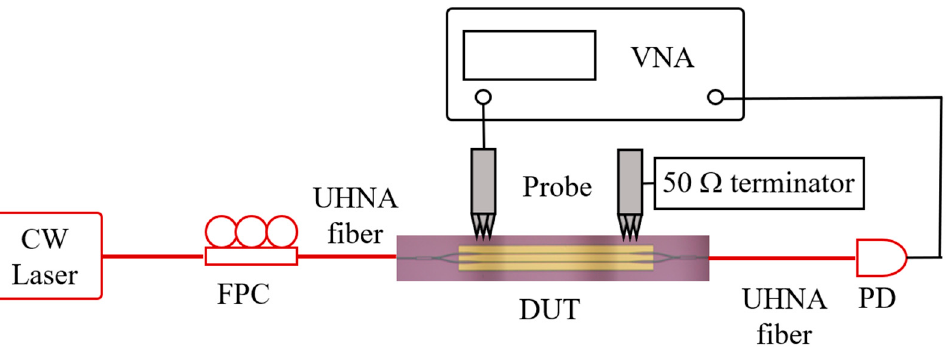
Figure 4. The schematic view of the measurement set-up for broadband EO response characterization. EDFA, erbium-doped fiber amplifier; DUT, device under test; FPC, fiber polarization controller; PD, photodiode; VNA, vector network analyzer.